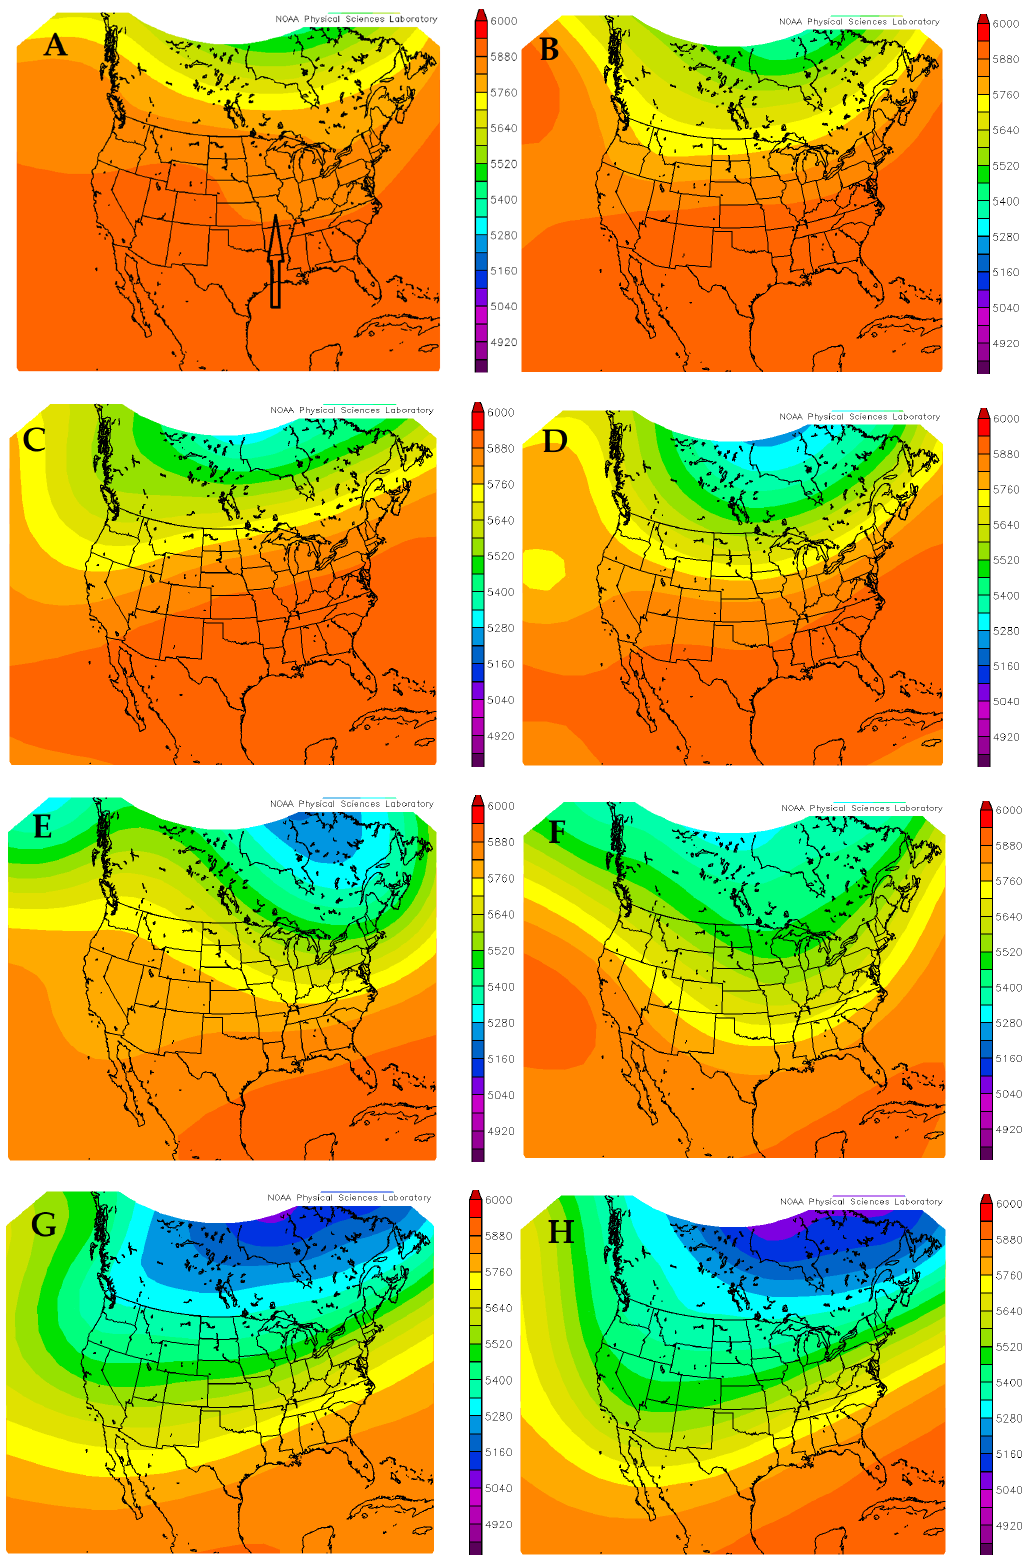
Figure 5. The 500 hPa height field for North America for the 10 days prior to an observed IE maximum; ( A ) 21 August, 2018, ( C ) 23 September, 2018, ( E ) 27 October, 2018, and ( G ) 14 February, 2019, and the 10 days following the IE maximum date for ( B ) case one, ( D ) case two, ( F ) case three, and ( H ) case four. The arrow in Figure 5A shows the location of Missouri,